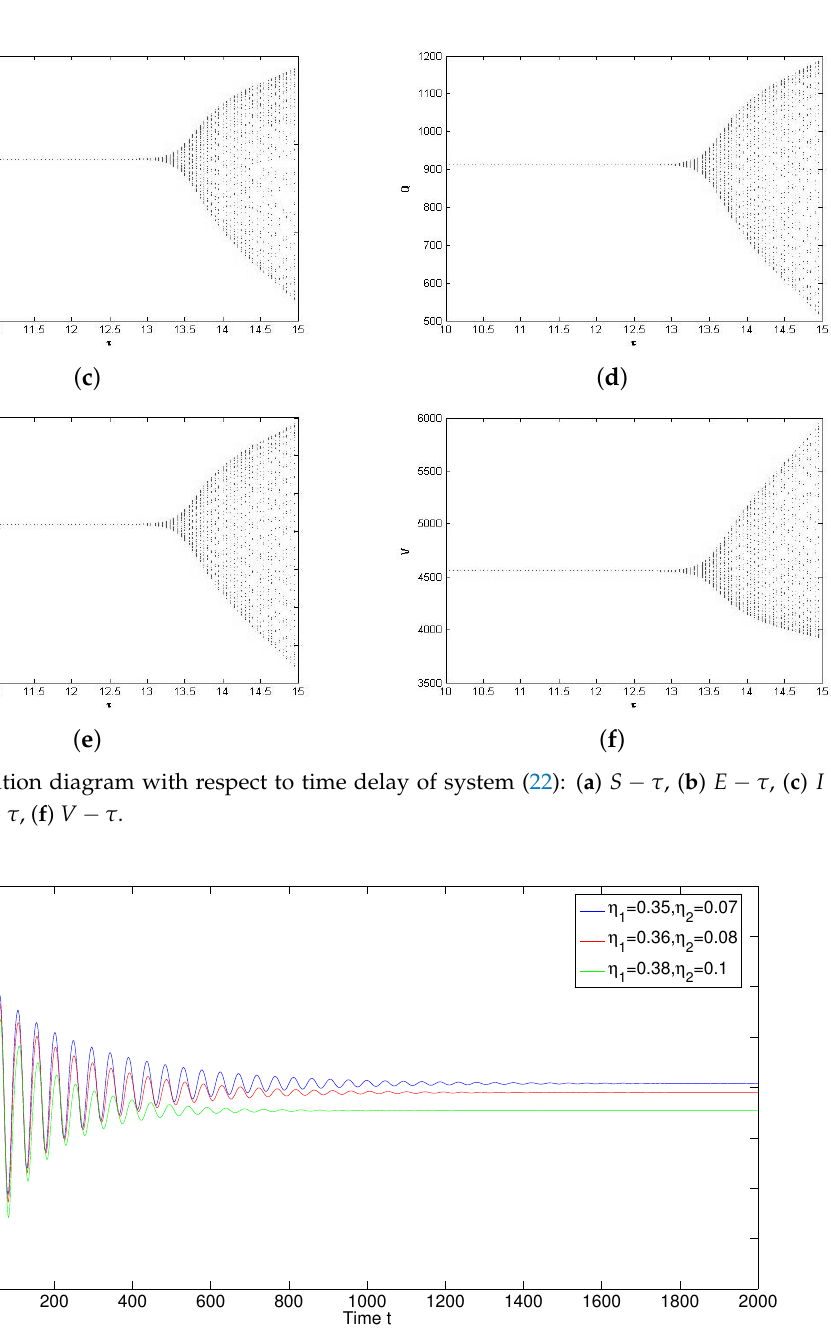
Figure 4. Time plots of I for different η 1 and η 2 at τ =